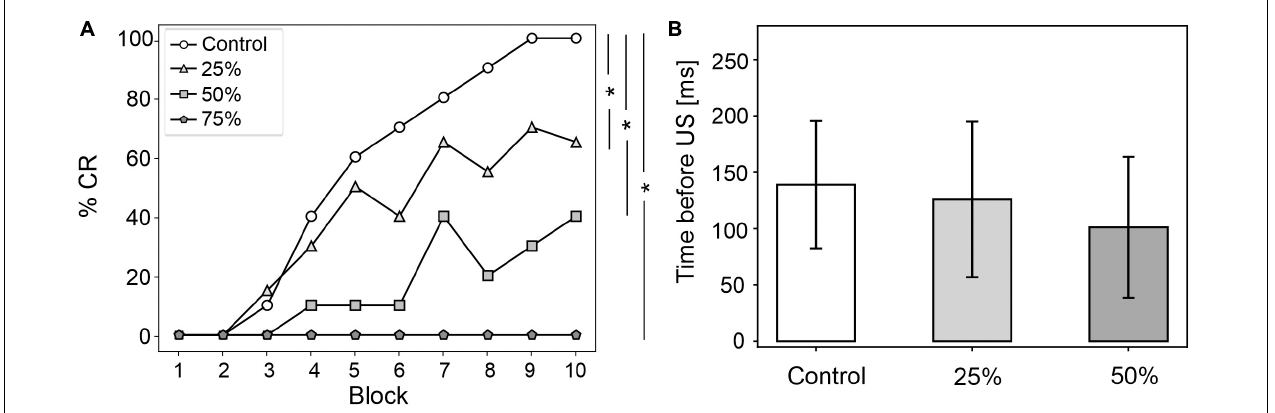
FIGURE 4 | EBCC behavior in the case of reduced olivocerebellar input (25%, 50 and 75%), compared to the control condition. (A) %CR along trial blocks. (B) CR timing with respect to US onset. Error bars indicate the standard deviation. Impaired condition with 75% IO-PC reduction is not represented in B) as no CRs were acquired during the simulation. * corresponds to p < 0.01 in the McNemar’s test for %CR and the Wilcoxon test for the CR onset